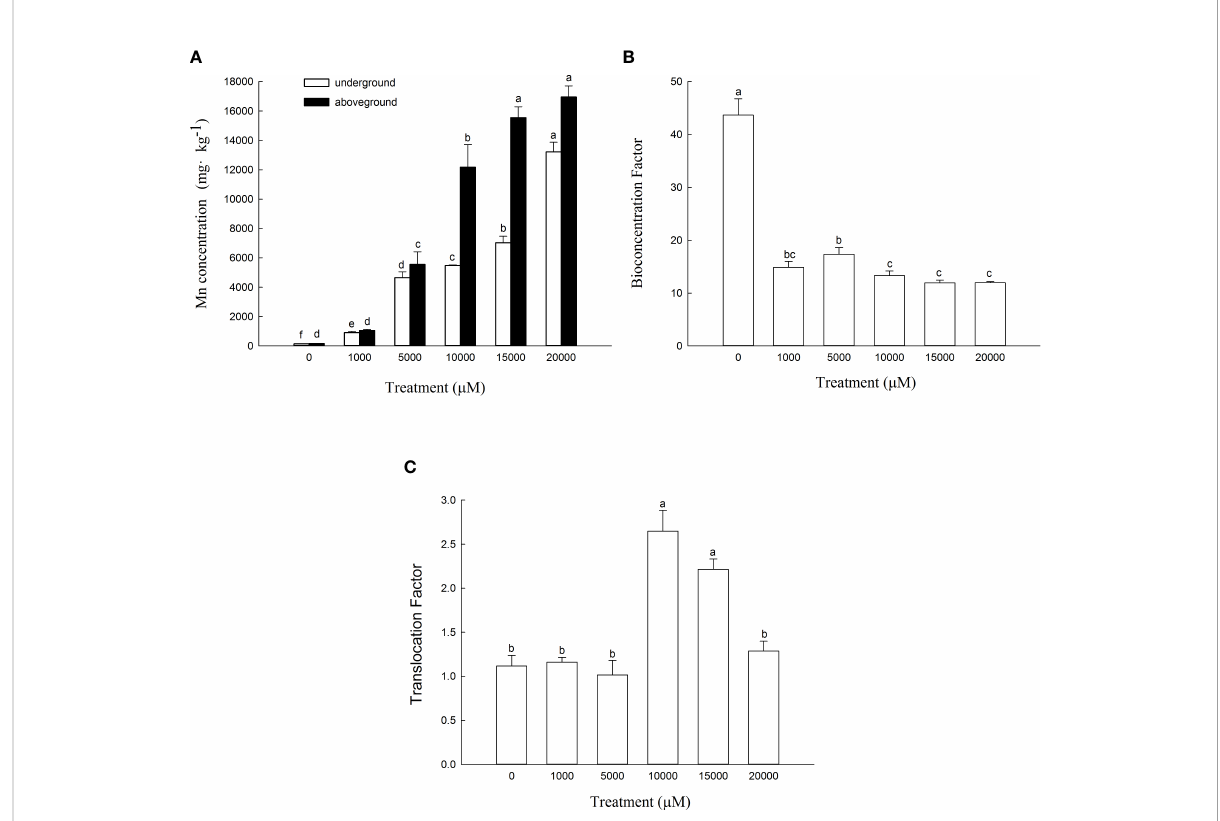
FIGURE 4 Mn concentrations in aboveground and underground parts (A) , bioconcentration factor (BCF) (B) and translocation factor (TF) (C) of D. carota under Mn stress. Data points and error bars represent mean and S.D. (n = 3). Values with different letters in the same parts of the plant indicate signi fi cant differences at the p < 0.05 level between different Mn concentrations according to the LSD